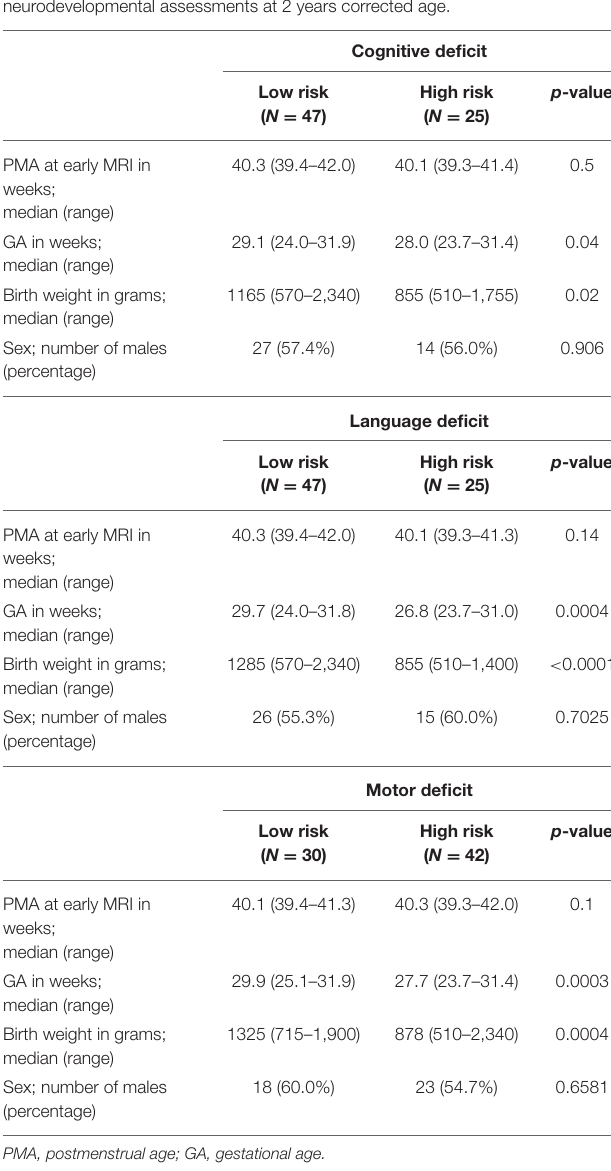
TABLE 3 | Demographic information of cohort II subjects with neurodevelopmental assessments at 2 years corrected